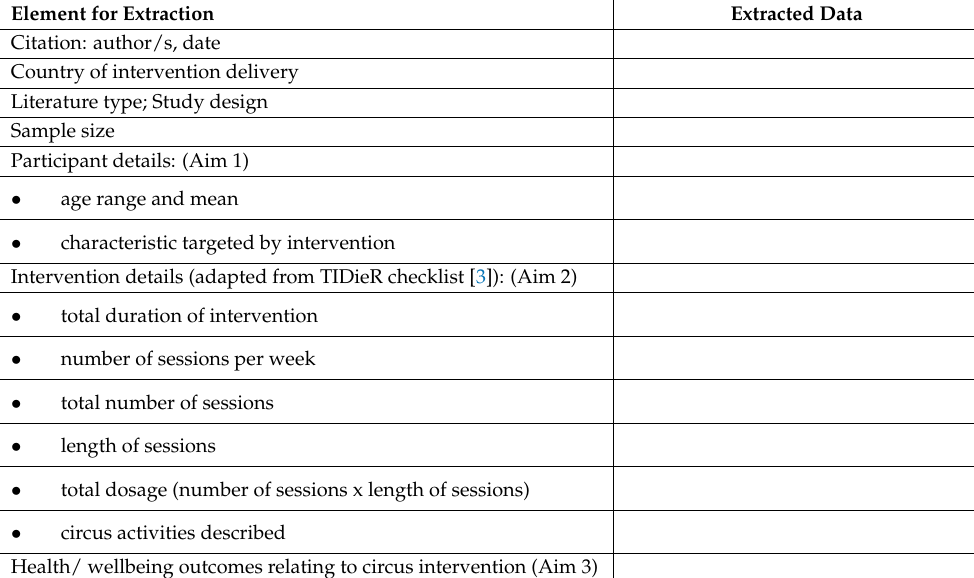
Table A3. Data extraction table used in Scoping